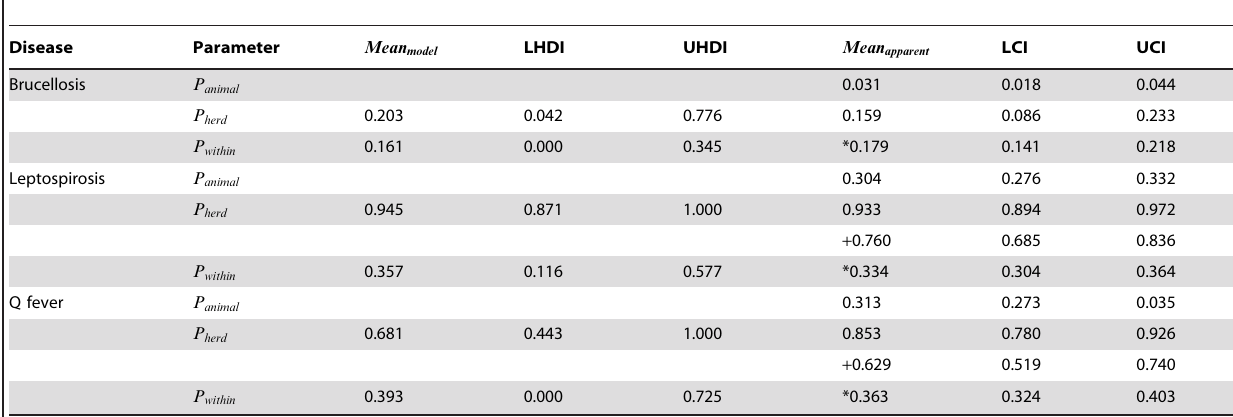
Table 2. Animal-level ( P animal ), herd-level ( P herd ) and within herd ( P within ) true (model based with 95% highest density intervals) and apparent (with 95% confidence intervals adjusted for study design effects) seroprevalences for cattle in the Adamawa Province of Cameroon to Brucella spp., Leptospira Hardjo and Q